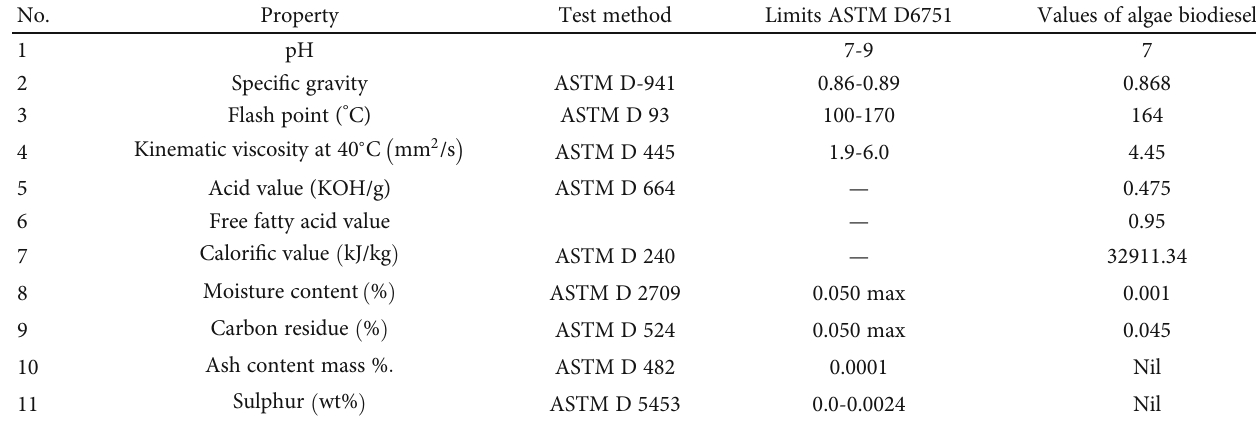
Table 7: Physicochemical characteristics of Spirulina microalgae